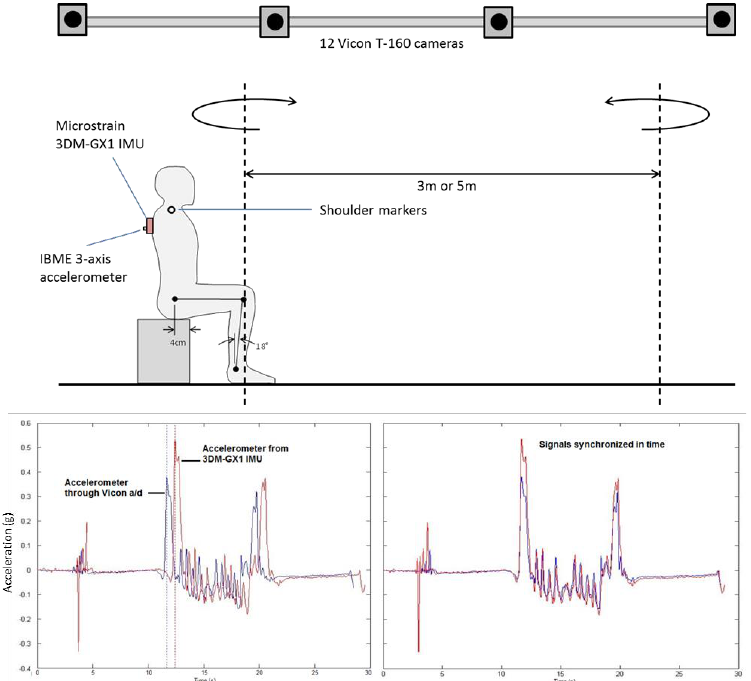
Figure 1. Experimental set-up for the study. Within the viewing volume of the motion capture system (12 Vicon T-160 cameras), the participant performed either a 3 m or 5 m Timed Up and Go (TUG) test,